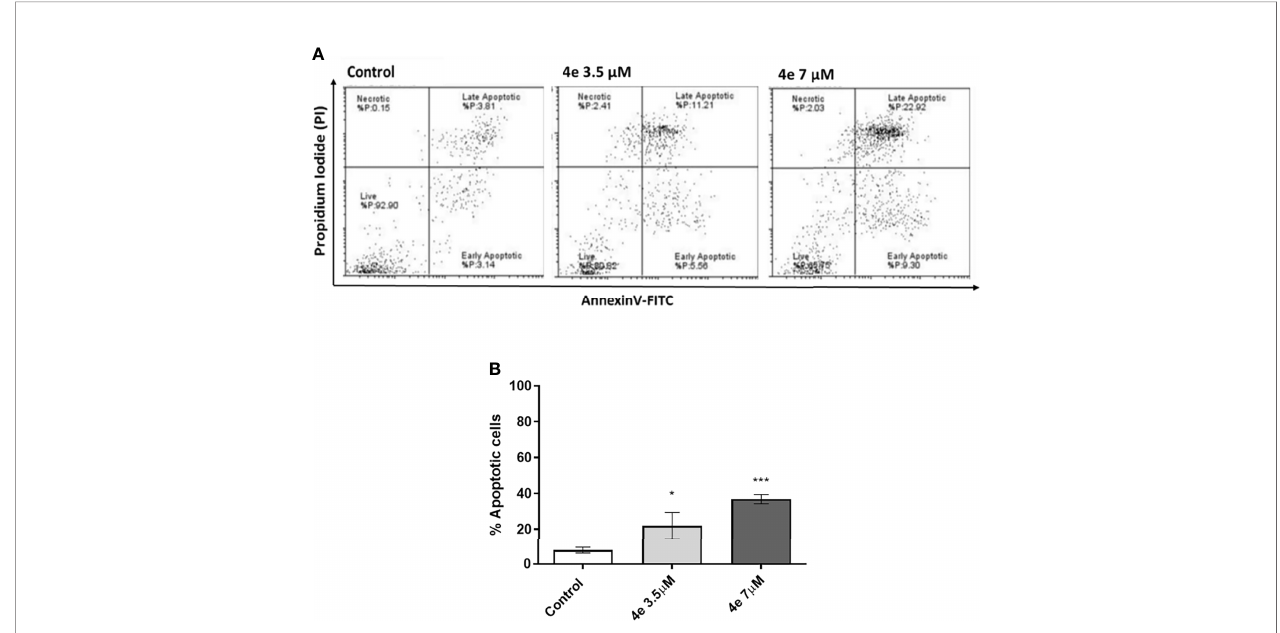
FIGURE 4 | Total apoptosis produced by 4e in HL60 cell line. (A) Apoptosis was measured via fl ow cytometry by AnnexinV-FITC/PI double staining upon 48 h treatment of cells with different concentrations of 4e . (B) Representative bar graph of total percentage of apoptotic cells as mean ± SEM of three independent experiments. *p < 0.05; ***p < 0.0005 as compared to the